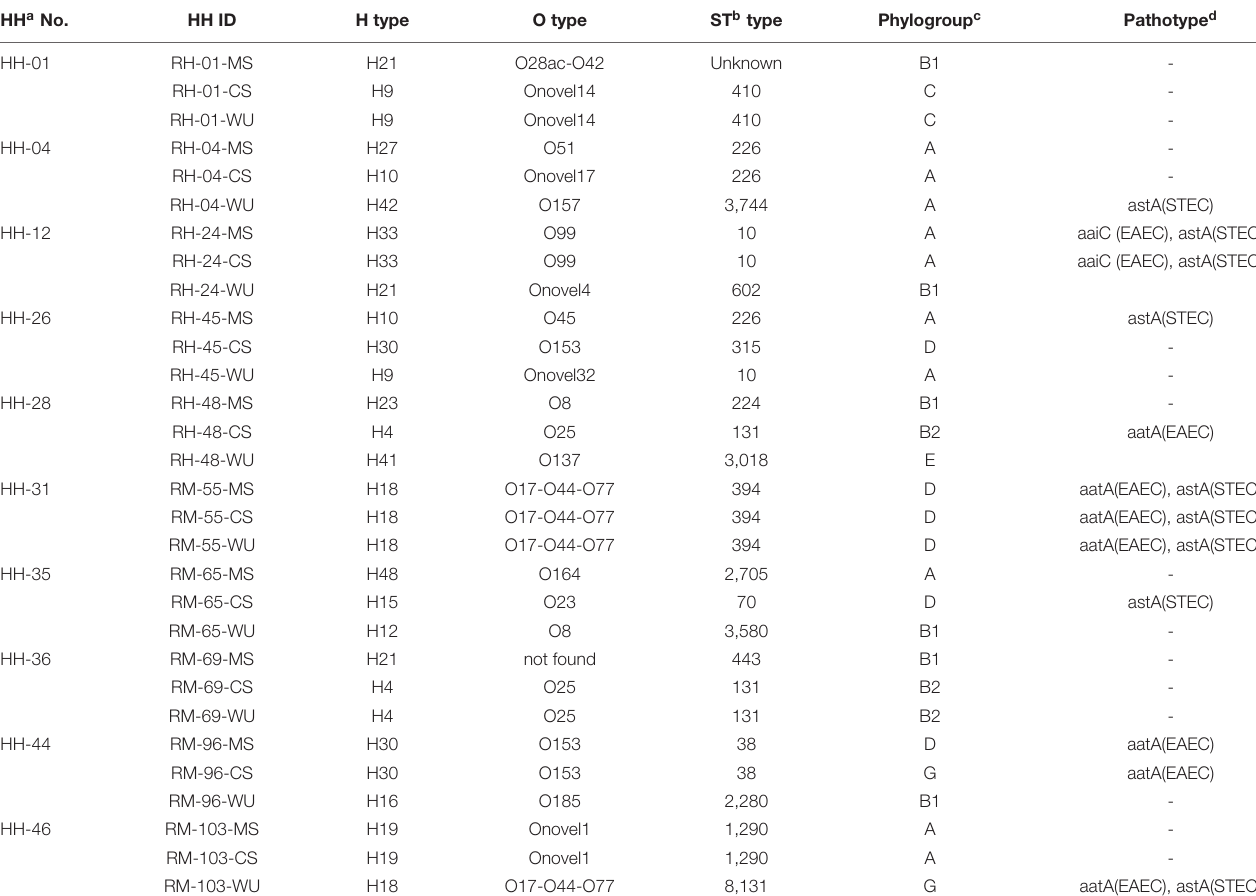
TABLE 1 | Distribution of serotype (O and H types), sequence type (ST), phylogroup, and pathotype in 30 E. coli isolates obtained from 10 households. HH a No. H type O type ST b type Phylogroup c Pathotype